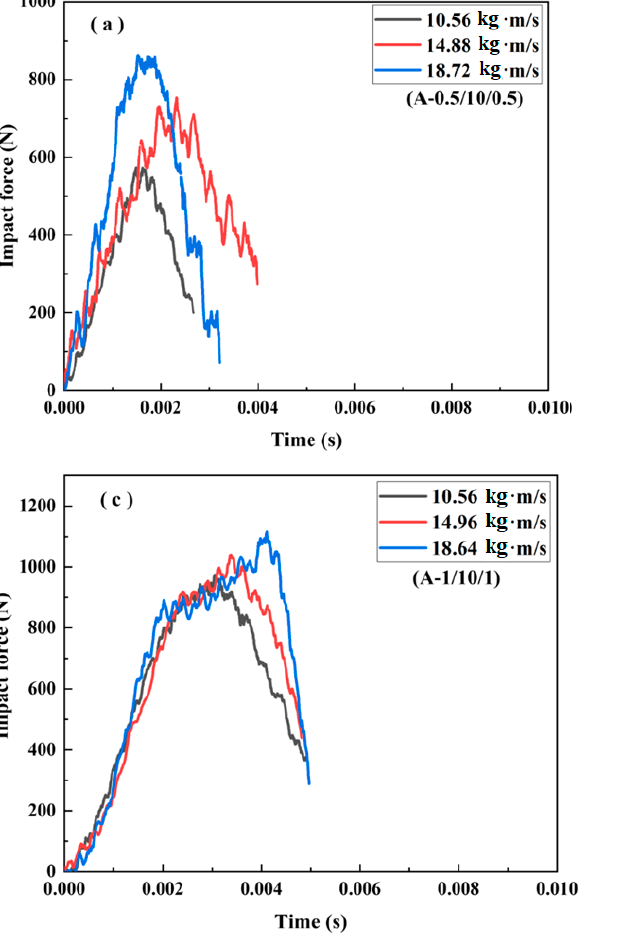
Figure 5. The impact force–time curves of the sandwich beams: ( a ) A-(0.5/10/0.5); ( b ) A-(0.5/20/0.5); ( c ) A-(1.0/10/1.0); ( d ) A-(1.0/20/1.0).